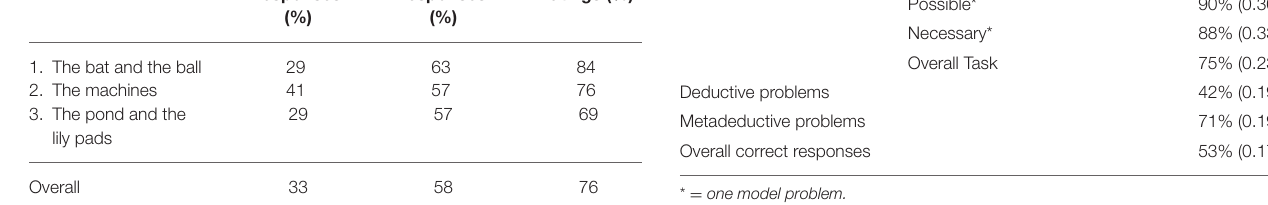
TABLE 1 | The percentages of correct and intuitive responses, and the ratings of difficulty for each of the problems in the cognitive reflection test. Problems